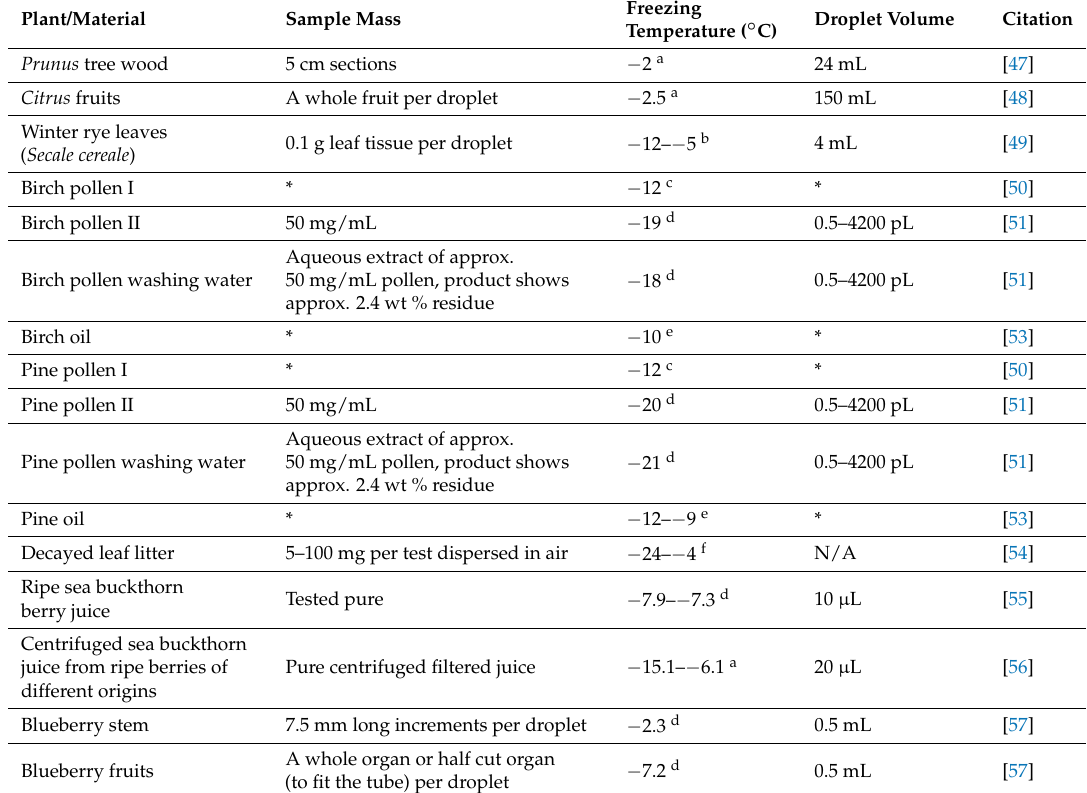
Table A1. The freezing temperature of different plant materials which are known to show INA, presented in the introduction. The table shows from left to right: the examined plant material, sample mass, the triggered freezing temperature, droplet volume/size for immersion freezing experiments (measuring INA with the INP immersed in a water droplet), and the corresponding citation. We use the word droplet here for a single freezing unit, not every method used for the data in the table below works with droplets, but rather with discrete volume units. The droplet size used to determine the INA of decayed plant leaf litter was not available. This table only includes selected examples for the samples presented in [50,51,53,57]. The definition of freezing temperatures varies and is indicated at the bottom of the table. Differences in methods and droplet sizes render comparisons between temperatures between studies